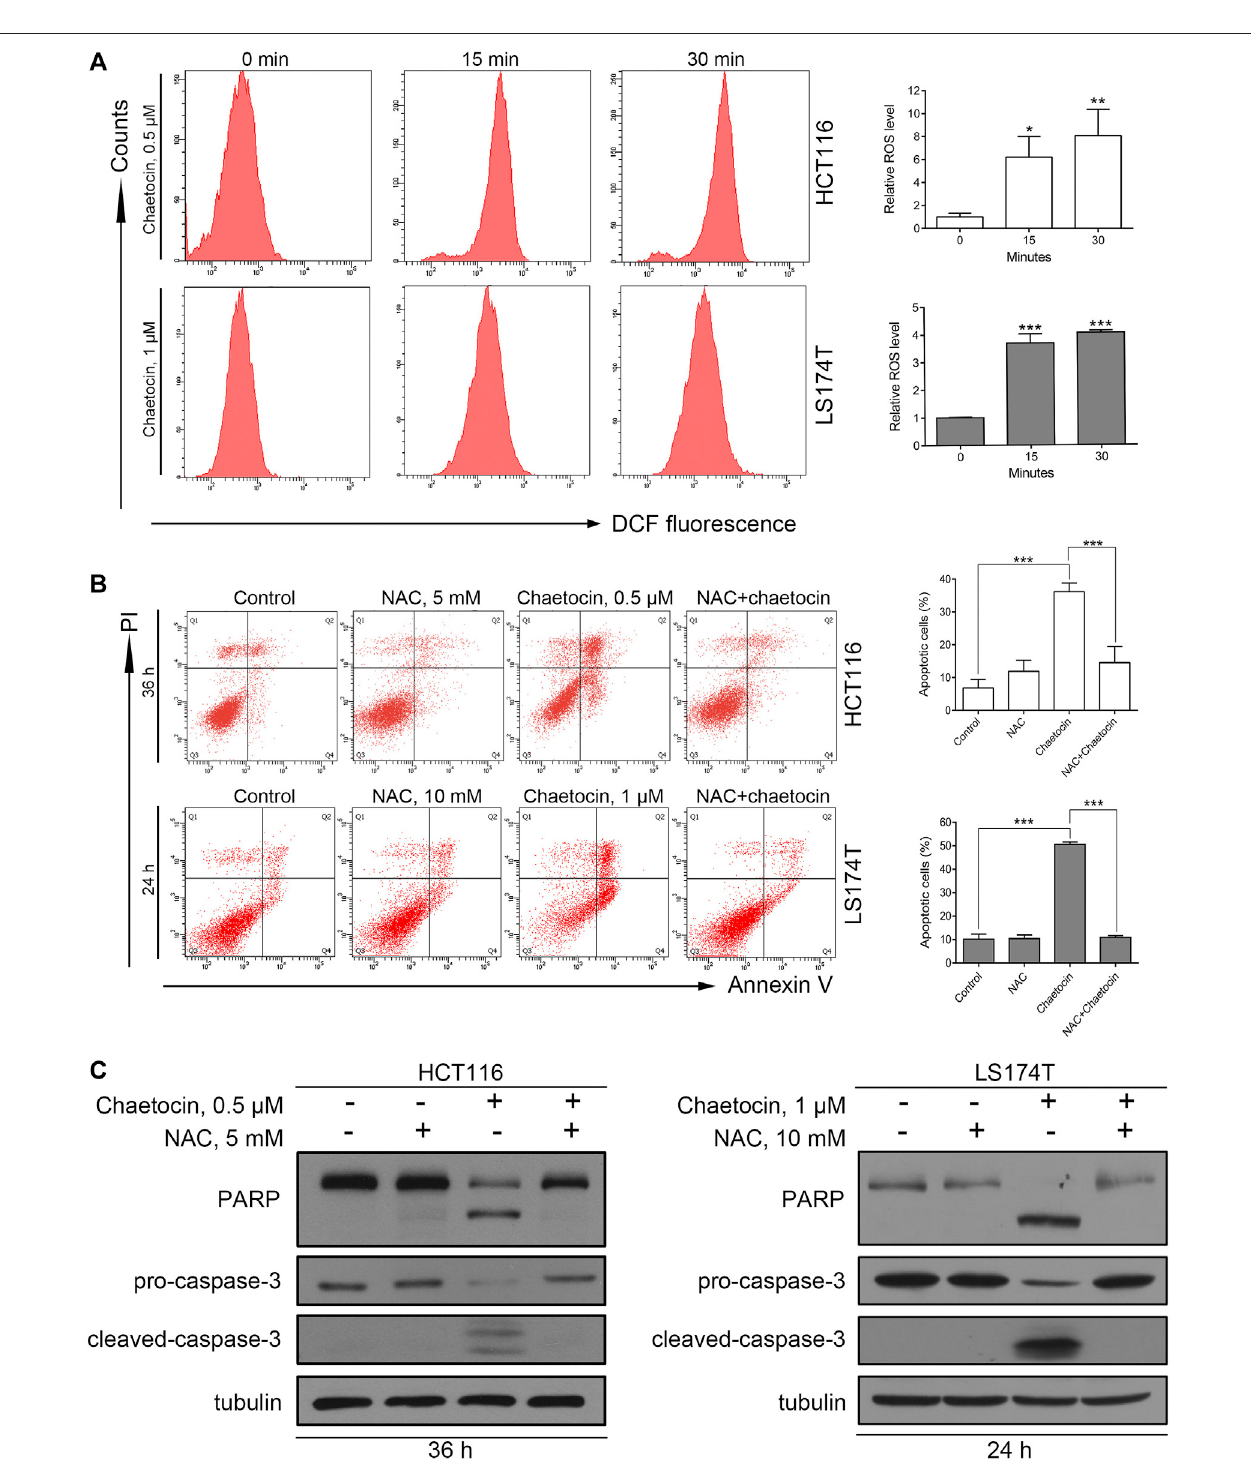
FIGURE 3 | Chaetocin-induced ROS accumulation is required for cell apoptosis. (A) ROS levels of HCT116 and LS174T cells were veri fi ed using fl ow cytometry, after DCFH-DA labeling and chaetocin treatments. HCT116 and LS174Tcells were pretreated with NAC for 2 h and then cotreated with chaetocin for another indicated times. (B) Flow cytometry analysis on apoptotic CRC cells. (C) Western blot of PARP and caspase-3 protein level. For (A) and (B) , results were shown as mean ± SD of three independent experiments. * p < 0.05, ** p < 0.01, *** p < 0.001, versus control group.